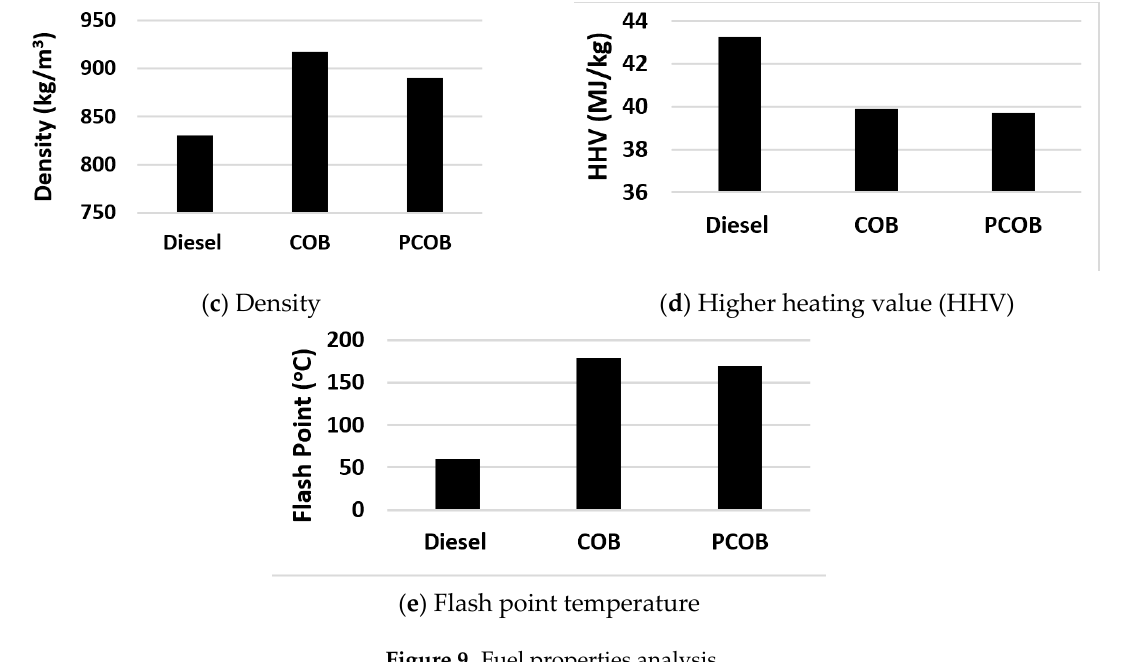
Figure 9. Fuel properties analysis.